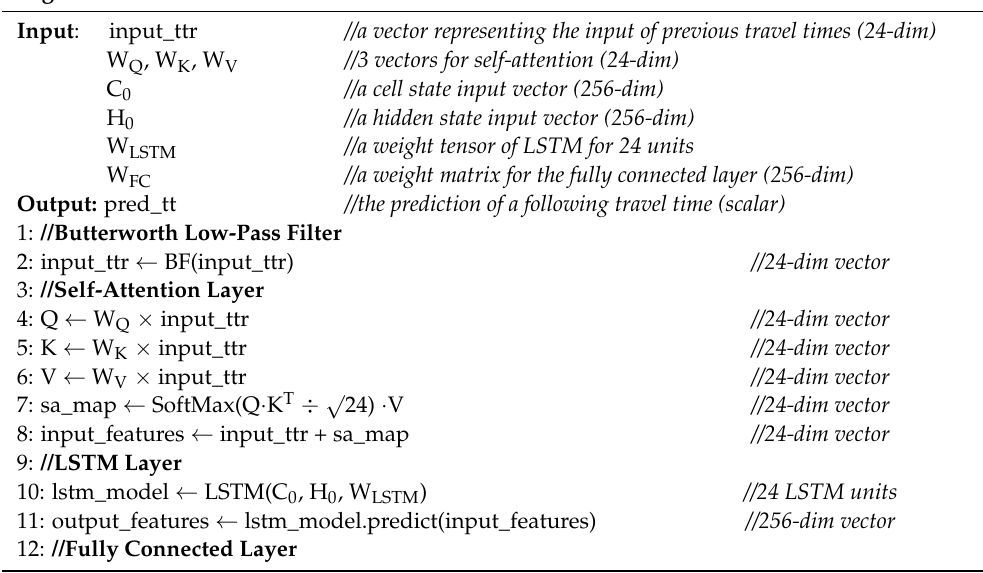
Algorithm 1. Model: Travel Time